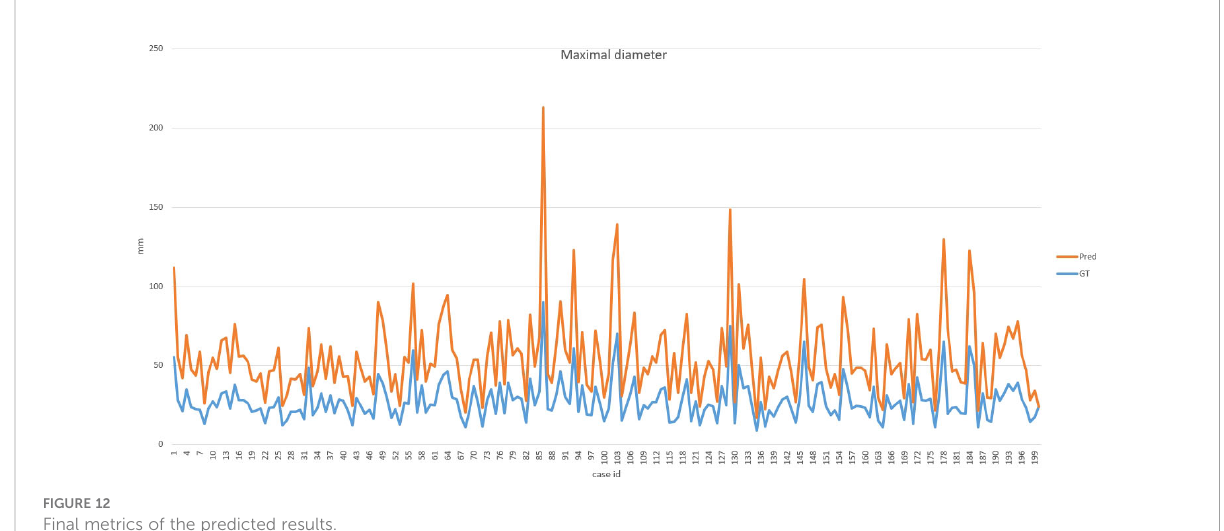
FIGURE 12 Final metrics of the predicted results.